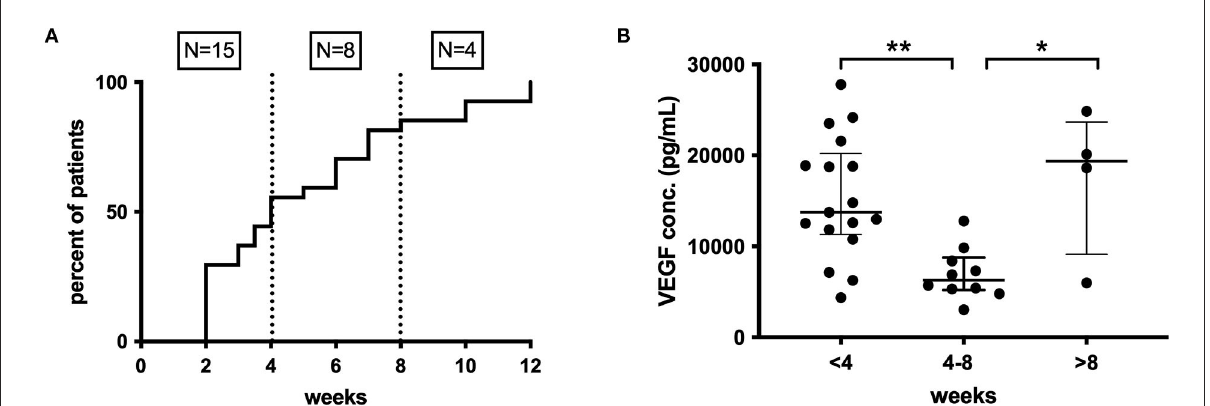
FIGURE8 (A) Time course of CSDH diagnosis following trauma, < 4 weeks ( n = 15), 4–8 weeks (n = 8), and after 8 weeks ( n = 4). (B) Pattern of intraoperative CSDH fluid VEGF concentrations at different time intervals post-trauma. Line (median) and bar (IQR). Statistically significant differences are denoted as p ≤ 0.005 (**) or p ≤ 0.05